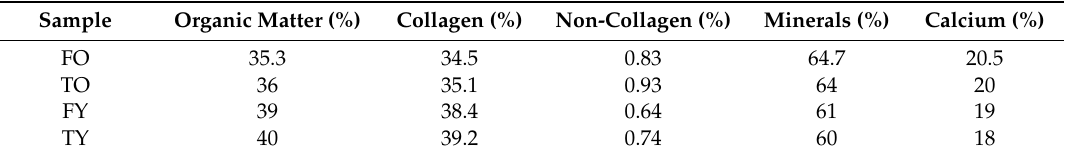
Table 8. Composition of collagen powders. FO = old femur, 10 years; TO = old tibia, 10 years; FY = young femur, 4.5 years; TY = young tibia, 4.5